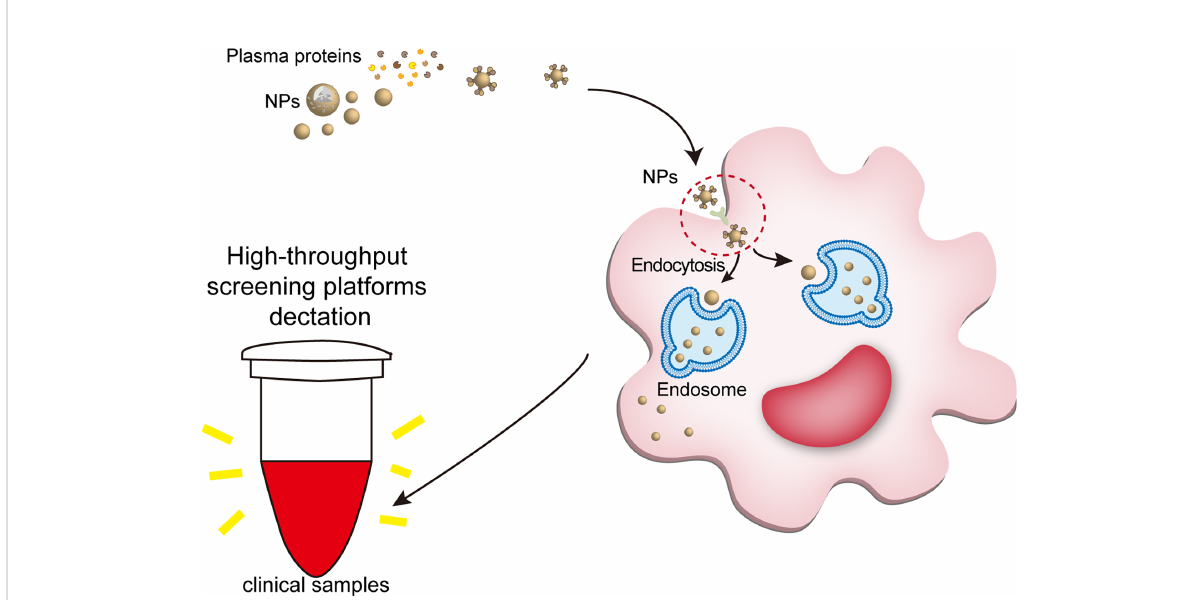
FIGURE 5 NPs engulfed by macrophages can be detected by clinical tools. The large number of proteins bound to the NP can trigger immediate recognition by macrophages. Ligand-receptor role is a part of way that plasma protein helps NPs enter macrophages. When nanomaterials interact with biological fl uids, after the formation of a protein corona, their main requirement is to interact with cell membranes (especially the molecule in the cell membranes surface) to show their biological effects, such as ligand-receptor role. For example, IgG, fi brinogen and complement proteins, promote the uptake of NPs by the macrophages utilizing the corresponding receptors expressed on the phagocyte surface, such as scavenger receptor on Kupffer cell. Once the NPs are endocytosed into macrophages, the nanotracer in macrophages of the samples can be tested by high- throughput screening platforms, such as optical nanosensor and other nano-detector. NPs,